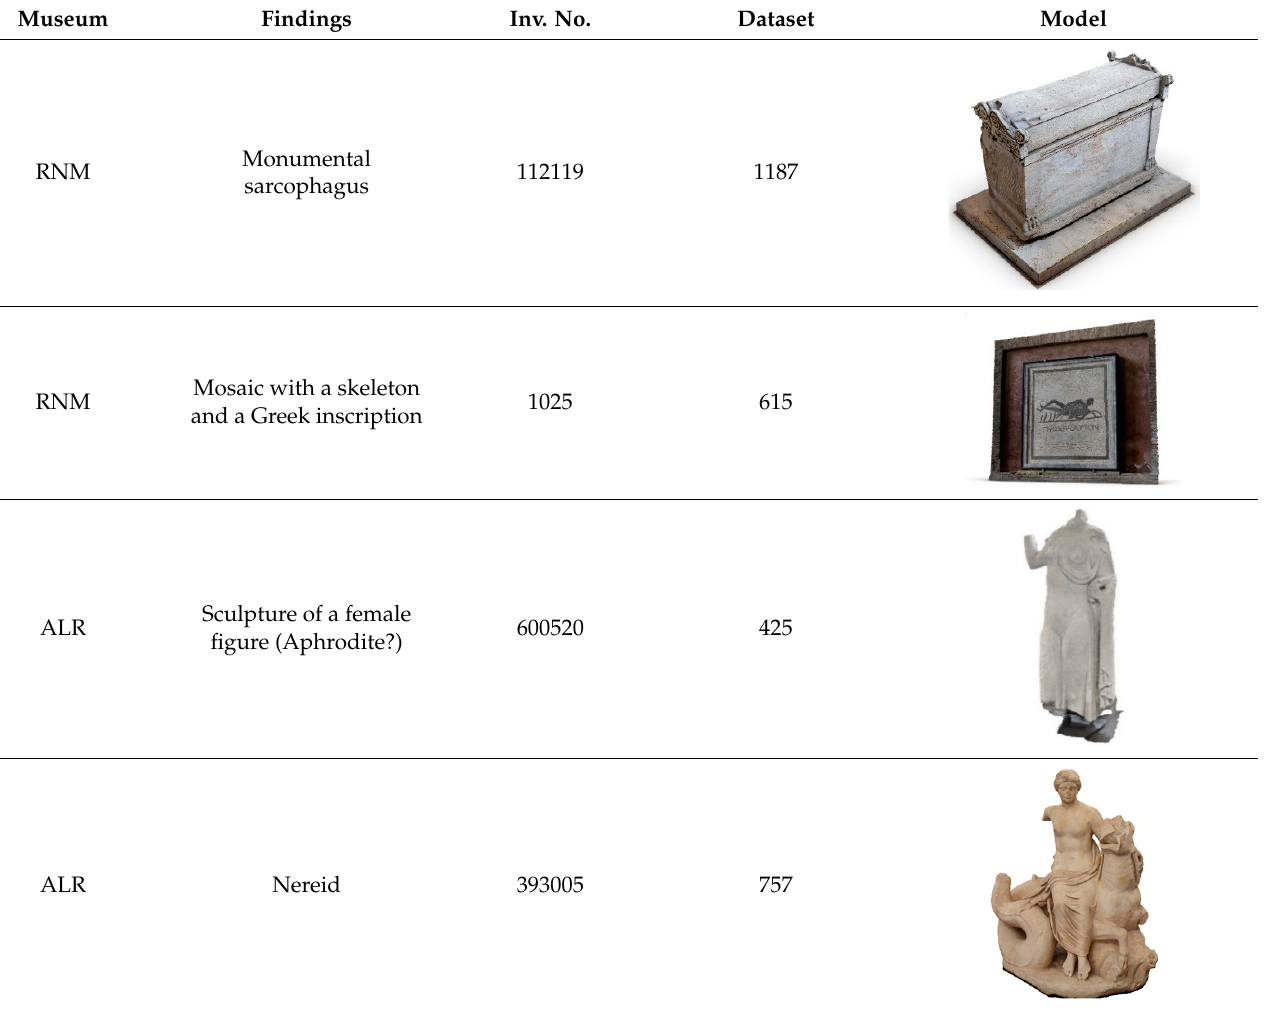
Table 1. The digitised sculptural heritage.